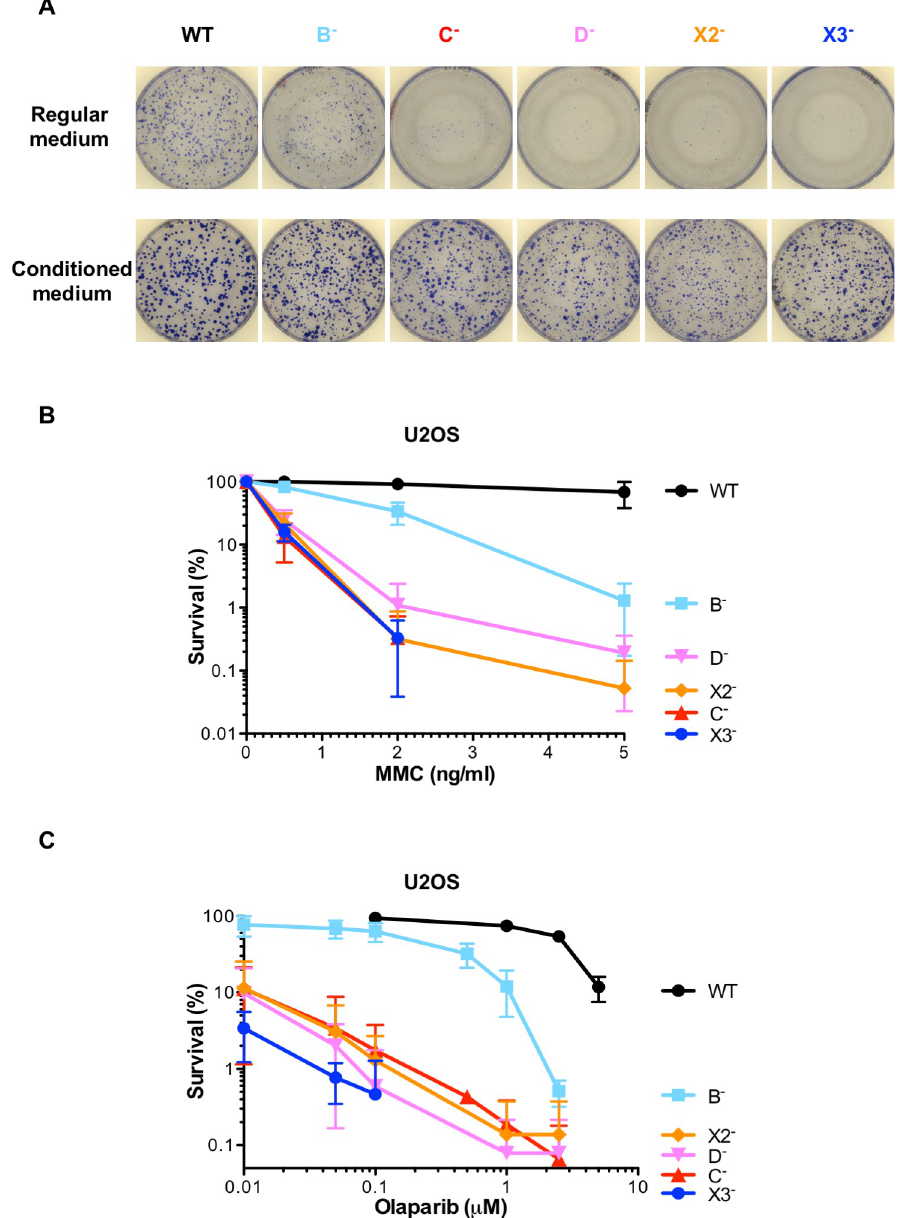
Fig 5. RAD51 paralog disruption sensitizes human U2OS cells to mitomycin C and olaparib. (A) Rescue of the plating efficiency defect of RAD51 paralog disrupted U2OS cells using conditioned medium. Images of the culture dishes stained with Coomassie to reveal colonies formed 7 to 10 days after seeding the wild-type and RAD51B mutant cells in regular versus conditioned medium, and after 14 to 15 days for the other mutants. (B) Survival curves obtained by clonogenic cell survival assays after treatment of exponentially growing U2OS cells with indicated doses of mitomycin C (MMC). Analyses of the mutant cells stably complemented with a retroviral construct expressing the corresponding wild-type allele are shown in S6A Fig. These experiments were performed at the same time. Results are presented as means +/- SD from at least three independent experiments. Some points and error bars do not appear on the graph due to log scale. (C) Survival curves obtained by clonogenic cell survival assays after treatment of exponentially growing U2OS cells with indicated doses of olaparib. Analyses of the mutant cells stably complemented with a retroviral construct expressing the corresponding wild-type allele are shown in S6B Fig. These experiments were performed at the same time. Wild-type cells were not analyzed at doses below 0.1 μ M of olaparib. Results are presented as means +/- SD from at least three independent experiments. Some points and error bars do not appear on the graph due to log scale.